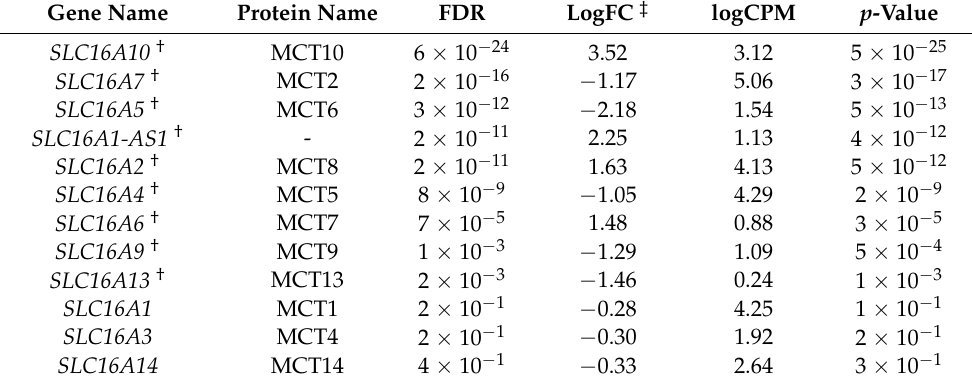
Table 1. Expression of MCT genes in PDAC stroma ( n = 123) relative to the epithelium ( n = 66). In total, 12 MCTs were identified, of which 9 showed significant differential expression between the stroma and epithelium, with the remaining MCTs having similar expression in these tissues. In addition to the protein-coding MCT genes, lncRNA SLC16A1-AS1 was also found to be downregulated in the tumour